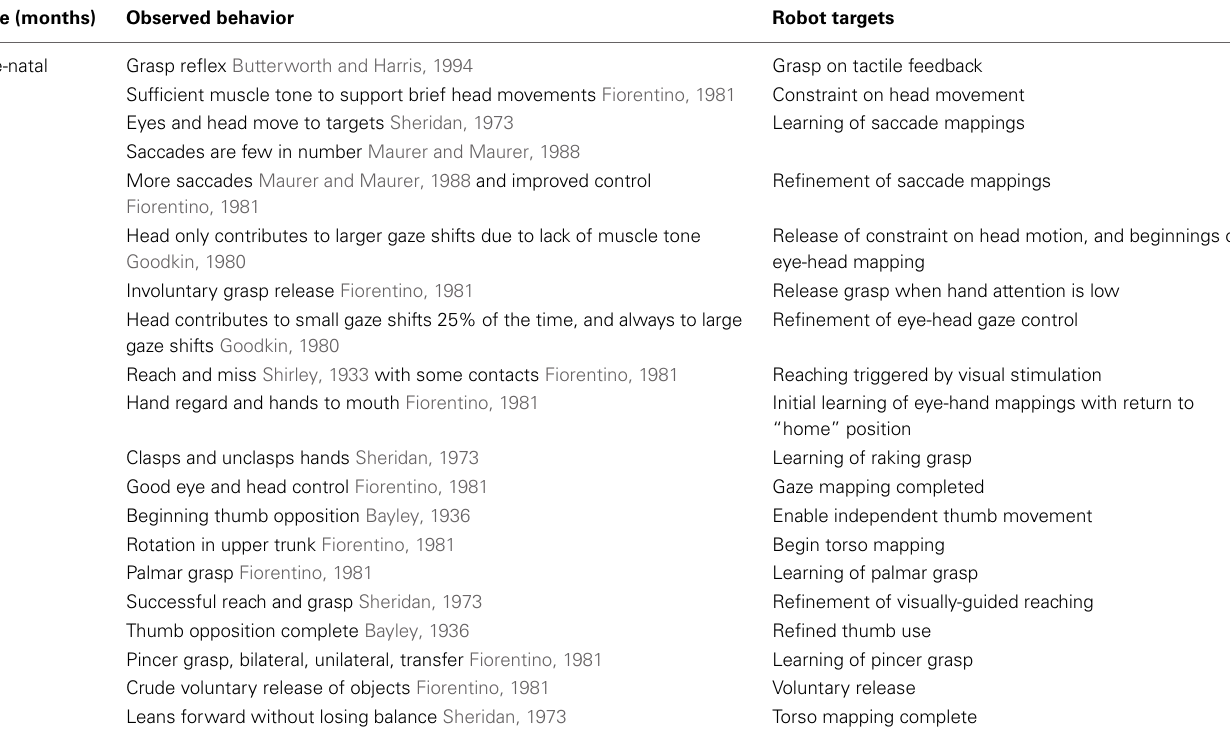
Table 1 | Infant development and learning